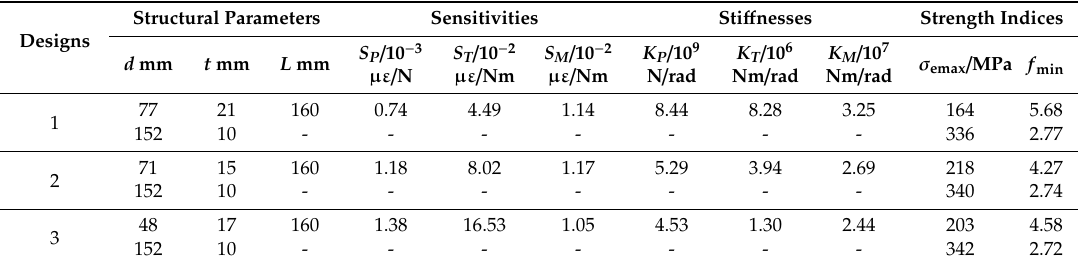
Table 3. Results presentation of three designs.